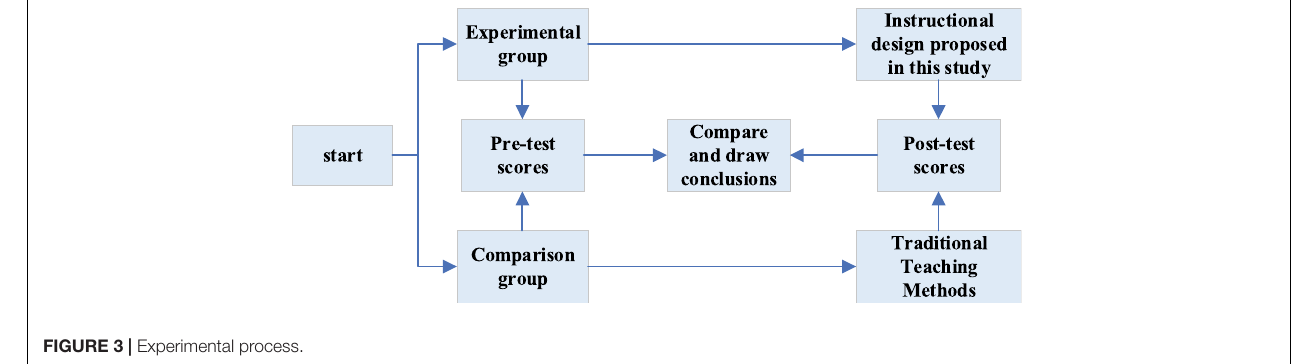
FIGURE 3 | Experimental process.